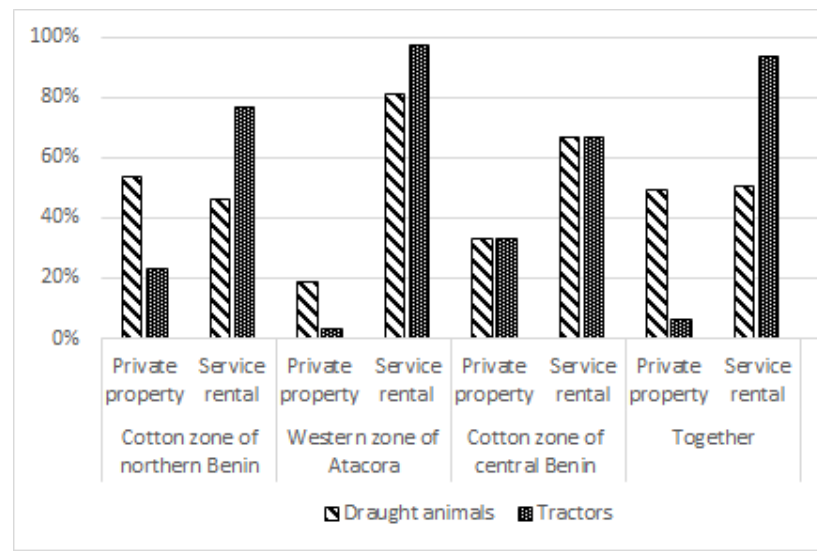
Figure 2. Sources of mechanization in cotton production.